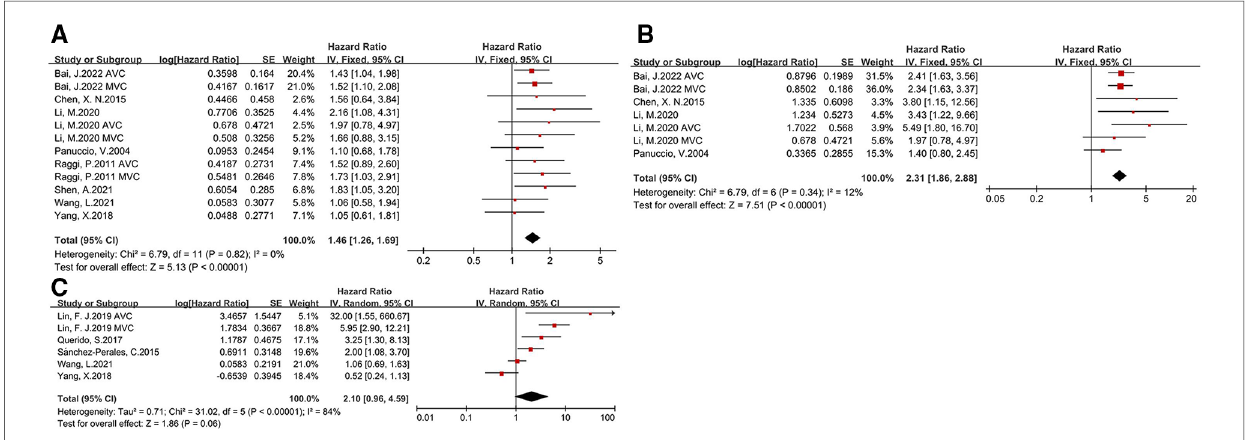
FIGURE 4 Forest plot of clinical outcomes for CKD patients with CVC [( A ) all-cause mortality, ( B ) cardiovascular mortality, ( C ) cardiovascular events].